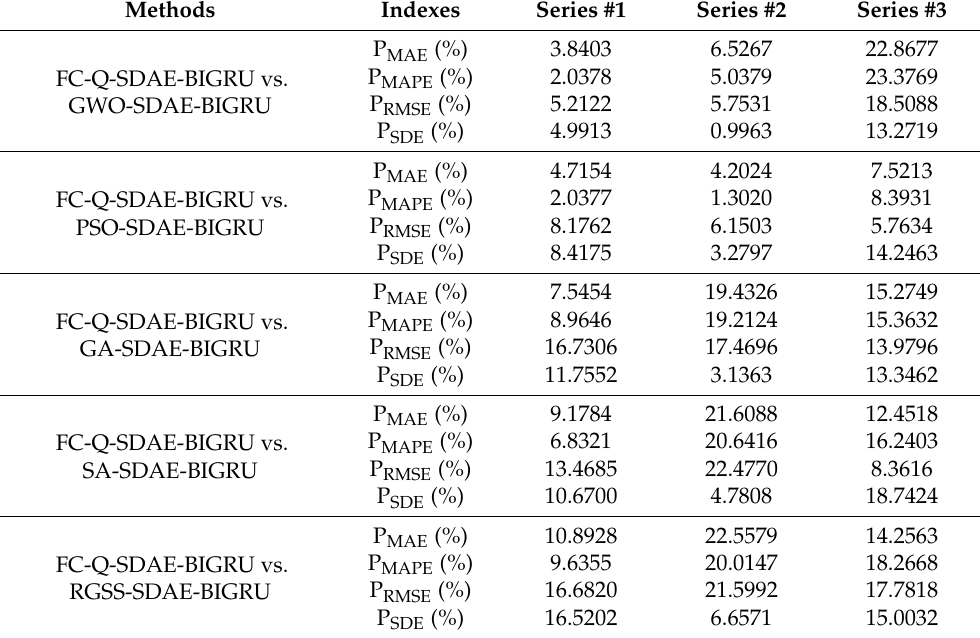
Table 2. The promoting percentages of the FC-Q-SDAE-BIGRU by the others.